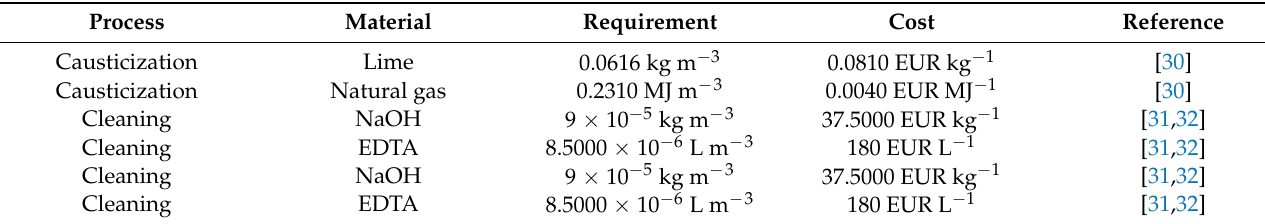
Table 5. Requirement of